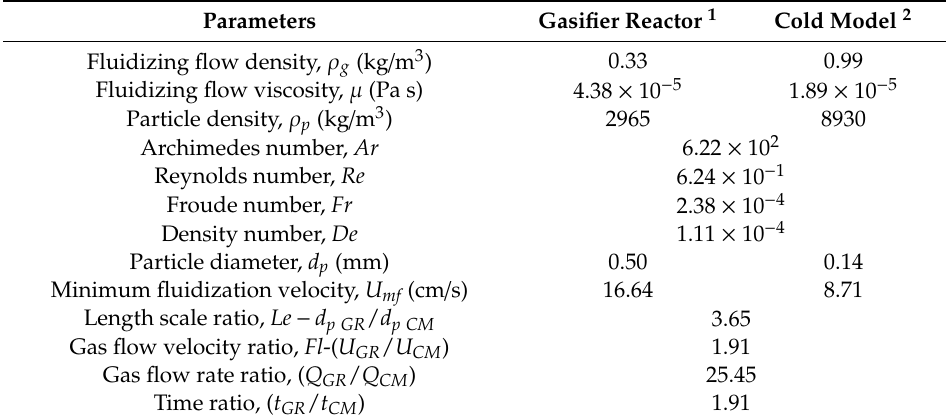
Table 1. Cold model